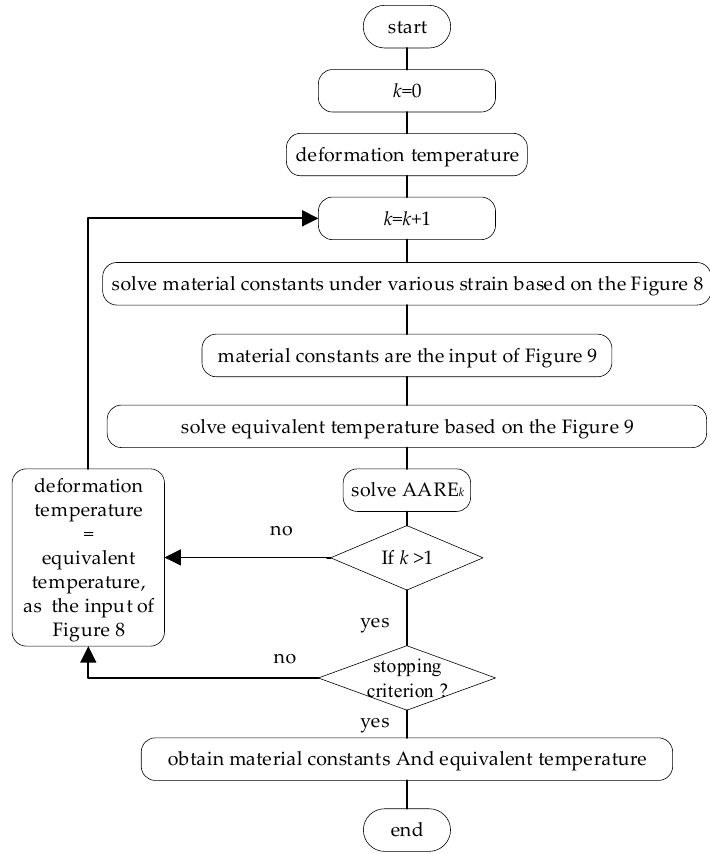
Figure 10. Process of establishing the modified strain-compensated Arrhenius-type (msA-type) equation.